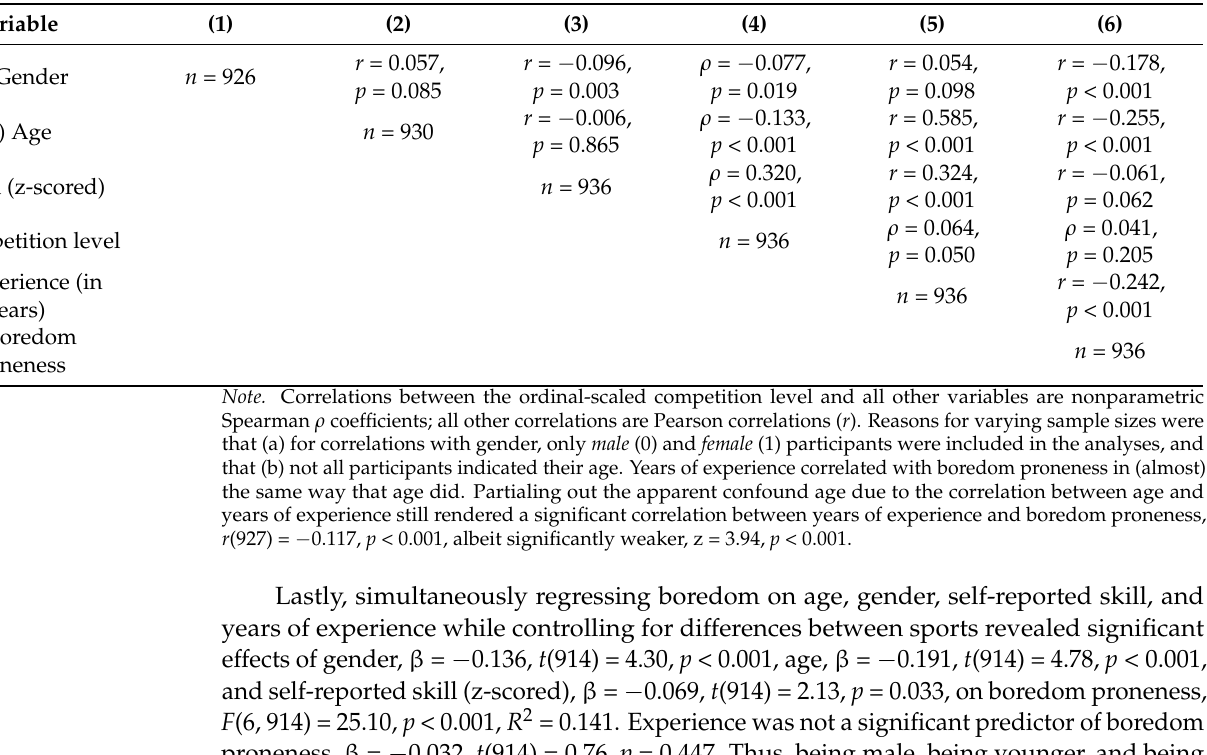
Table 3. (Non)Parametric correlations between gender, age, skill (self-reported), highest competition level, experience, and boredom proneness across all sports.